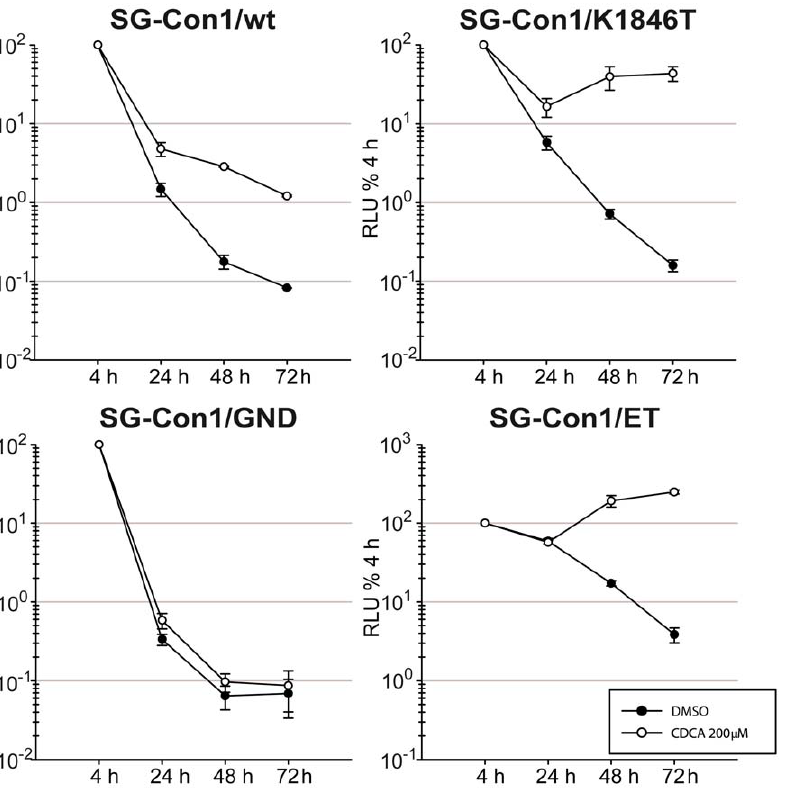
Figure 5. CDCA increases replication of Con1 wild type and cell culture adapted replicons. Given subgenomic Con1 replicons with or without replication enhancing mutations were transfected into Lunet G-Luc cells. At 4 h post transfection cells culture media were replaced with culture fluid with or without 200 m M CDCA. RNA replication was determined by luciferase assays and is expressed relative to the luciferase activity determined 4 h post transfection.